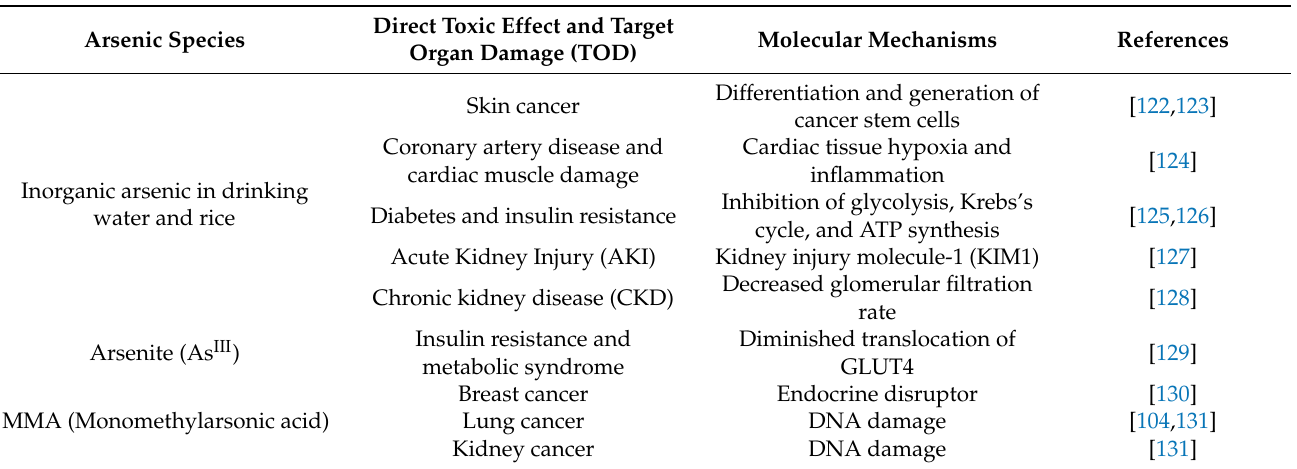
Table 5. Direct effects of arsenic species and their metabolites with respective mechanisms in different chronic